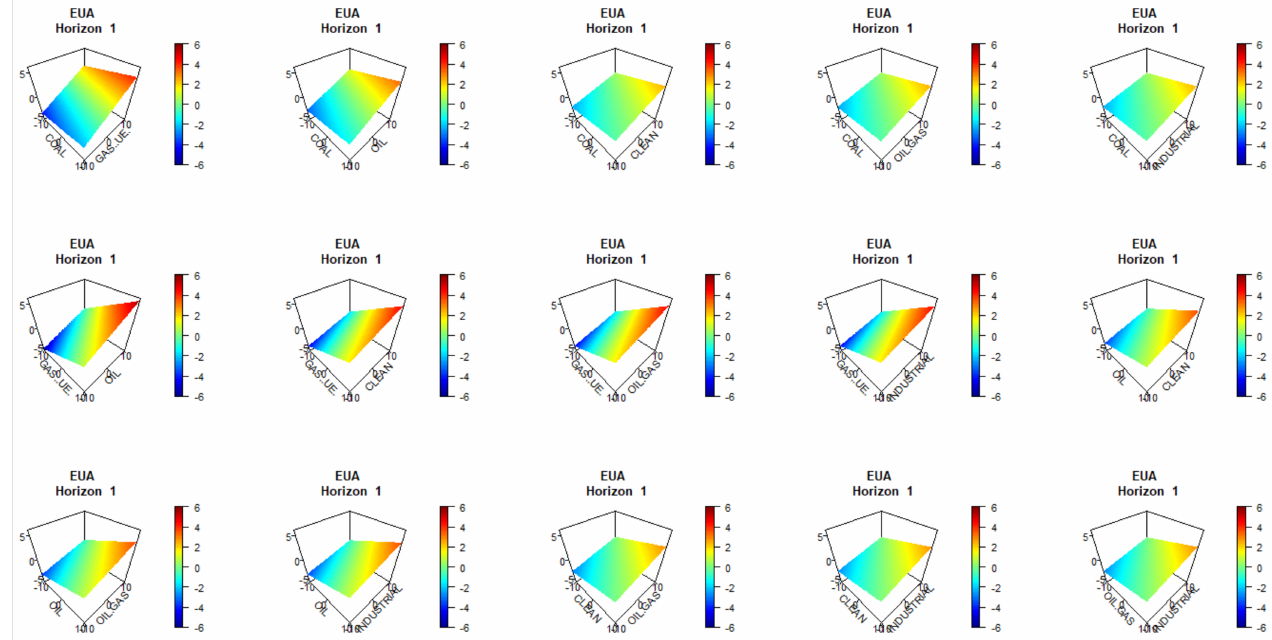
Figure 10. Matrix graph with the response surfaces of the conditional mean of EUA to bivariate impulses in all pairs of combinations of the rest of the